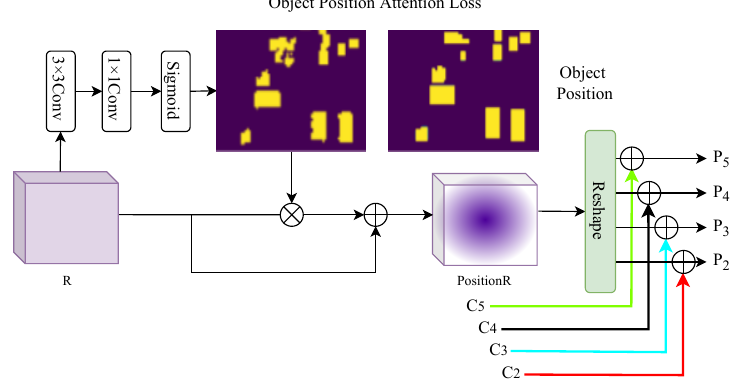
Figure 5. The Target-Focusing Block